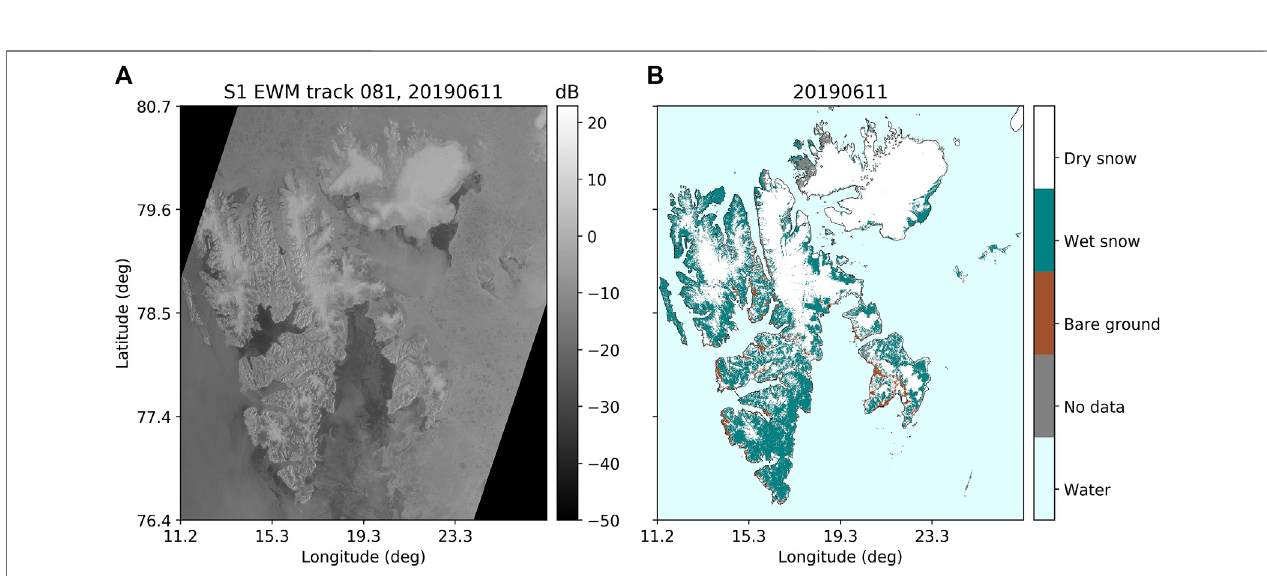
FIGURE 4 | (A) Sentinel-1 SAR backscatter data from track 081 on 11 June 2019 and (B) the classi fi ed wet snow map for 11 June 2019 where dark blue areas indicate wet snow and white areas correspond to dry snow. Brown areas indicate bare ground.